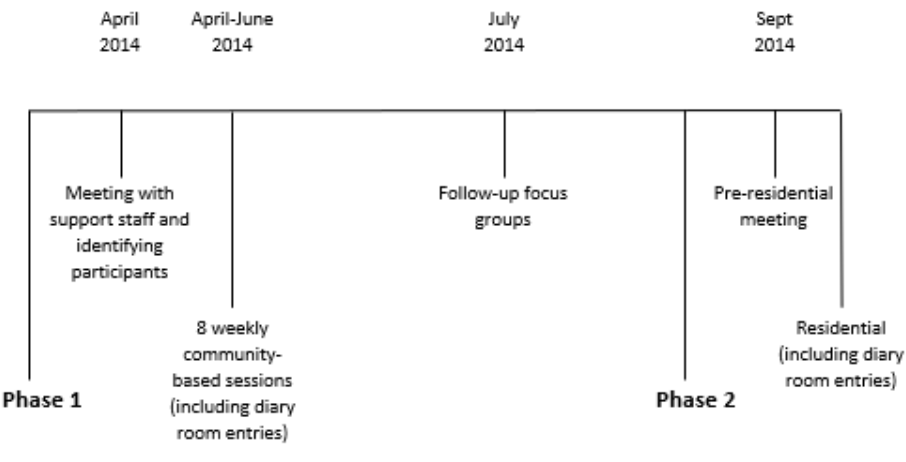
Figure 1. Intervention Timeline.